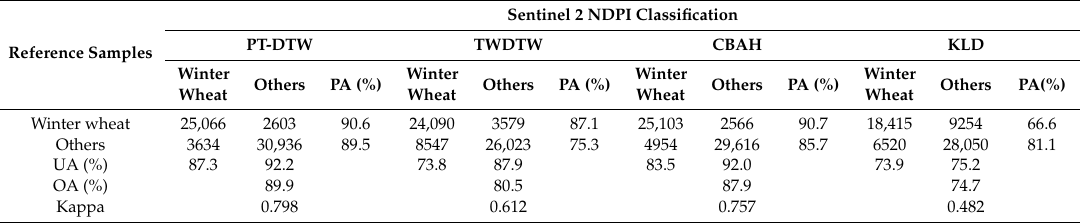
Table 2. Accuracy assessment of four methods. Expressed in number of pixels. Sentinel 2 NDPI Reference Samples